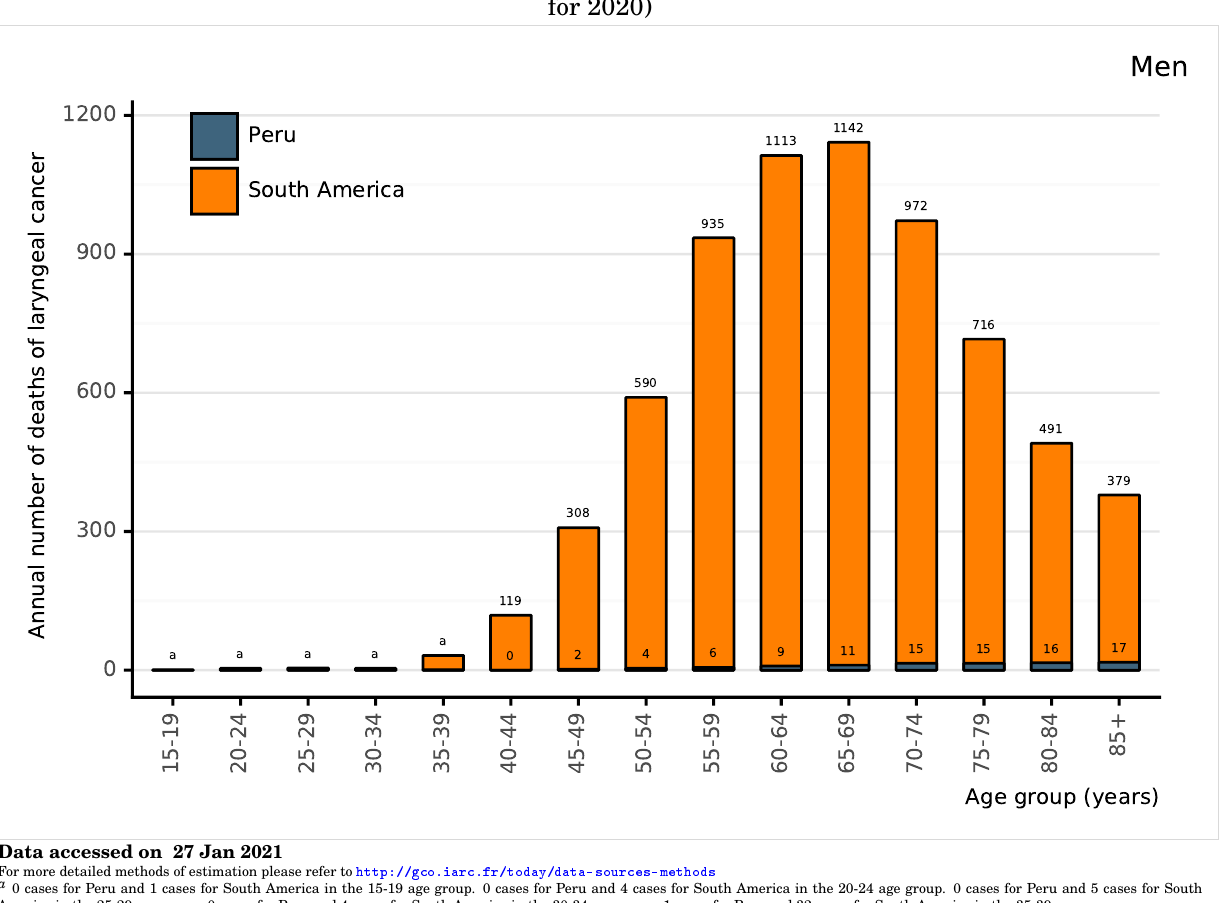
Figure 133: Annual number of deaths of laryngeal cancer among men by age group in Peru